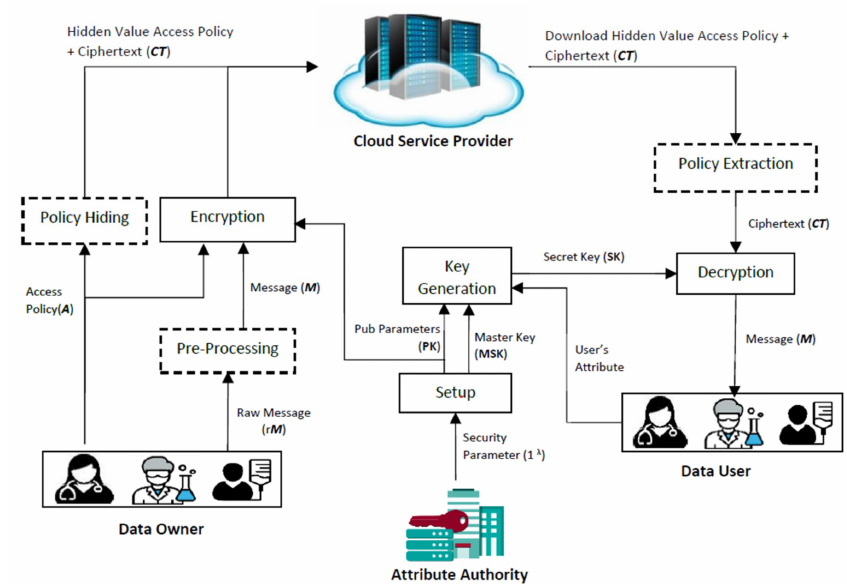
Figure 2. System